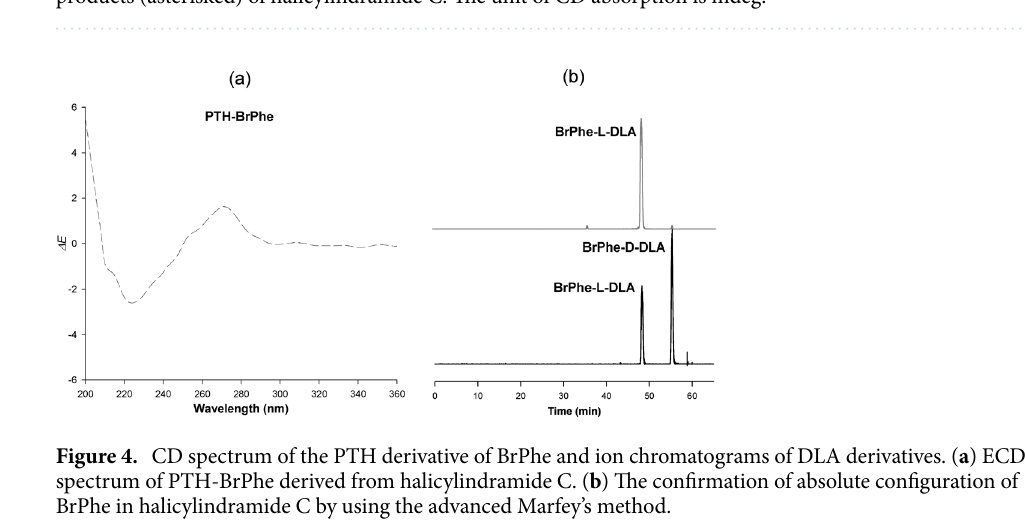
Figure 3. Ion chromatogram (dark) and CD absorption chromatogram (light) of the Edman degradation products (asterisked) of halicylindramide C. The unit of CD absorption is mdeg.